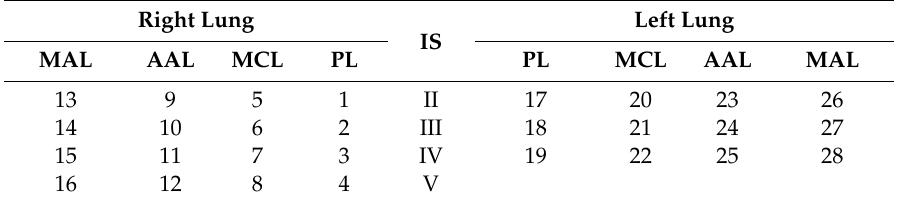
Table 3. Scheme of ultrasound examination of the lungs ( n = 28 scans) [18–21].